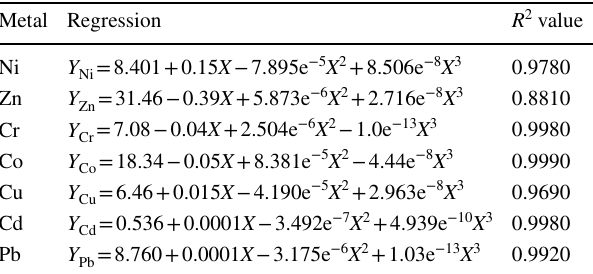
Table 4 Regression models for distribution pattern of heavy metals in Alaro River sediment Metal